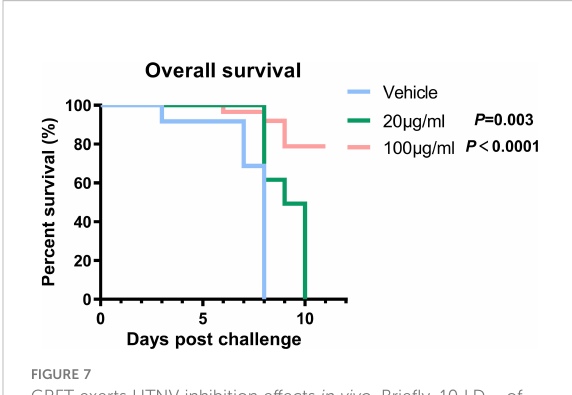
FIGURE 7 GRFT exerts HTNV inhibition effects in vivo . Brie fl y, 10 LD 50 of HTNV was pretreated with 20 m g/ml (0.4 mg/kg) or 100 m g/ml (2 mg/kg) of GRFT for 1 h, and the mixture was used to inoculate suckling mice intracranially. Among them, 17 mice were in the control group (DMEM-only vehicle), 11 in 20 m g/ml, and 14 in 100 m g/ml. Mice were observed for 10 days, and the survival of the mice was recorded every day, presented as Kaplan – Meier survival curves, and analyzed using the log-rank test. GRFT, grif fi thsin; HTNV, Hantaan virus; DMEM, Dulbecco ’ s modi fi ed Eagle ’ s